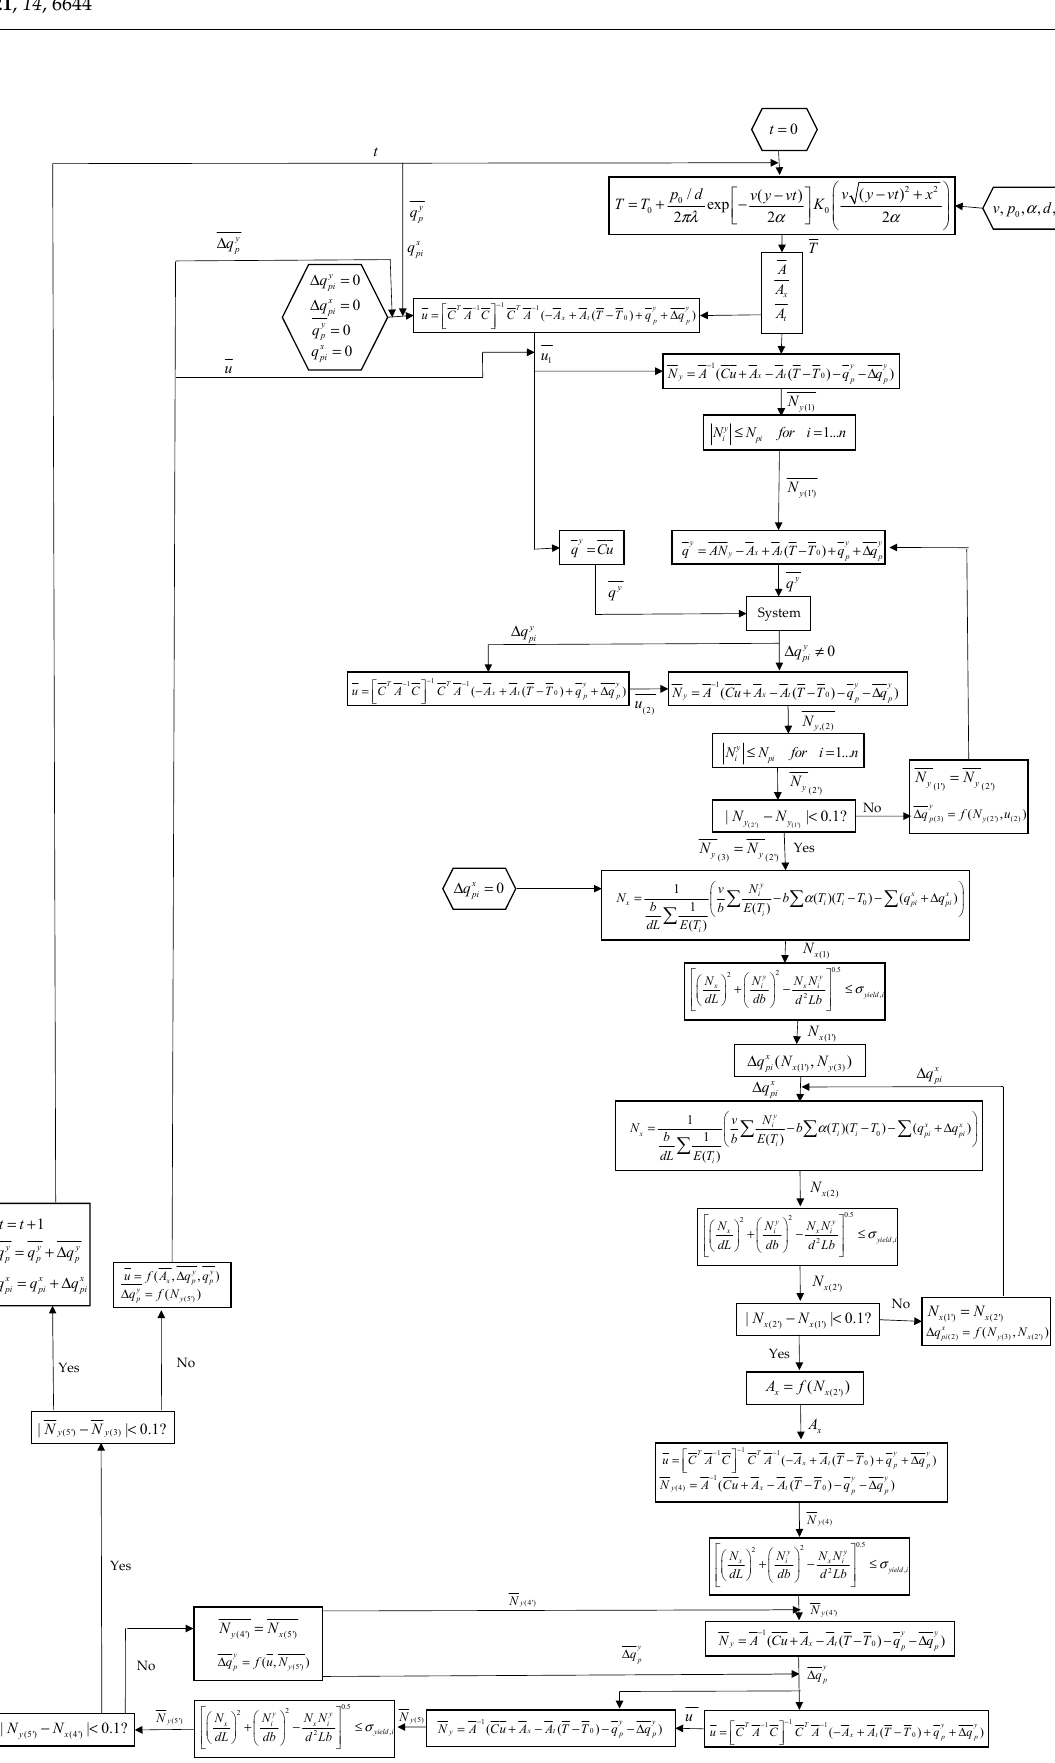
Figure A1. Flow chart of the analytical model.